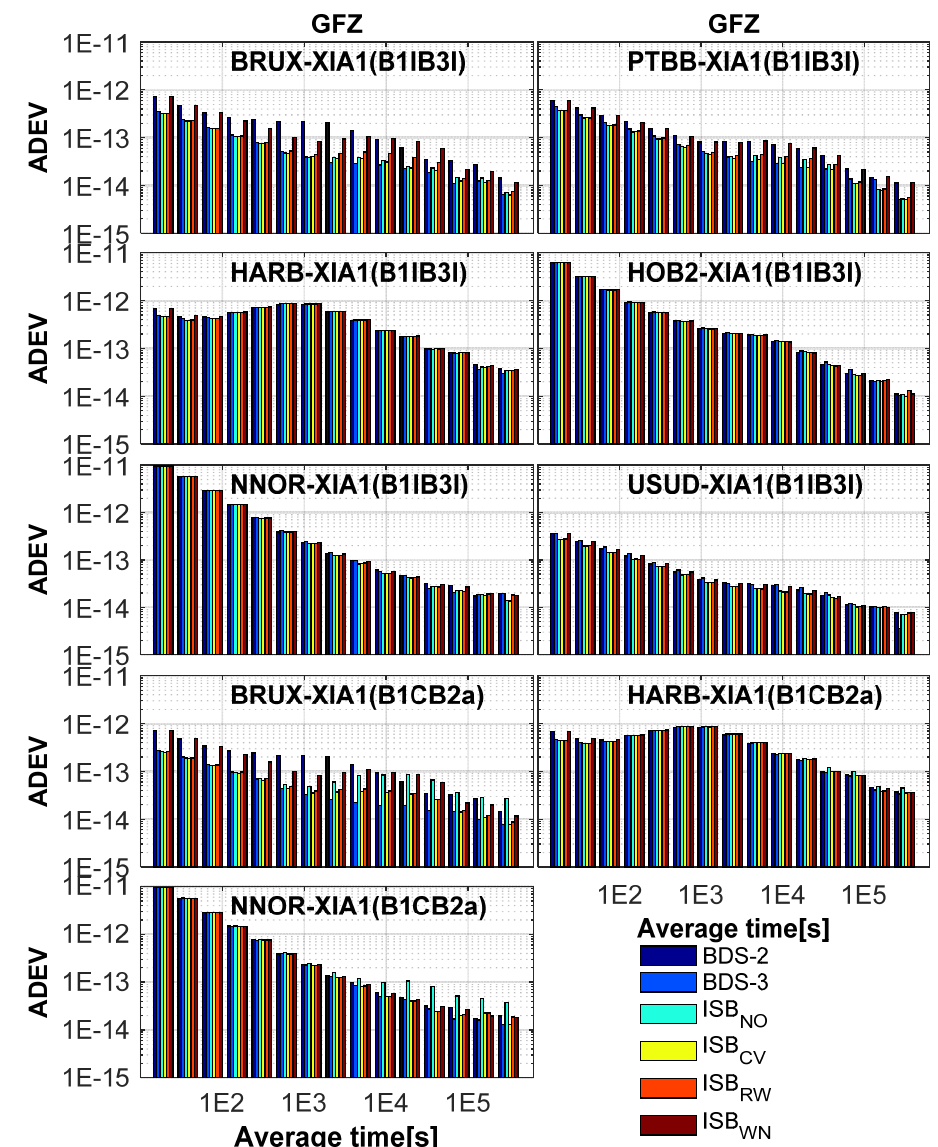
Figure 15. Allan deviation (ADEV) of BDS-2-only, BDS-3-only, and BDS (BDS-2/BDS-3 using four ISB stochastic models) solutions using GFZ products from DOY 101 to 130, 2020.